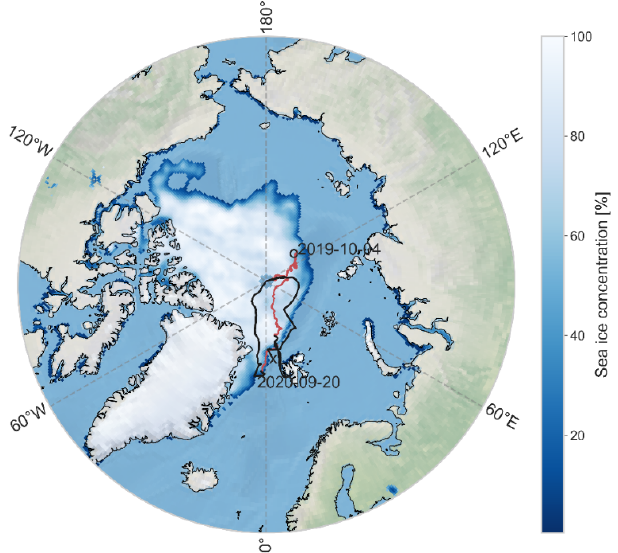
Figure A1. Track of RV Polarstern during the MOSAiC expedi- tion in the central Arctic (Schmithuesen, 2021a, c, d, e, b). Drift (red line) started in October 2019 and ended in September 2020. The black lines show periods where the ship was in transit. The sea ice extent is displayed from September 2019 at the annual mini- mum. We used sea ice data from the National Snow and Ice Data Center (Maslanik and Stroeve, 1999). The background map is made with Natural Earth (https://www.naturalearthdata.com/, last access: 6 October